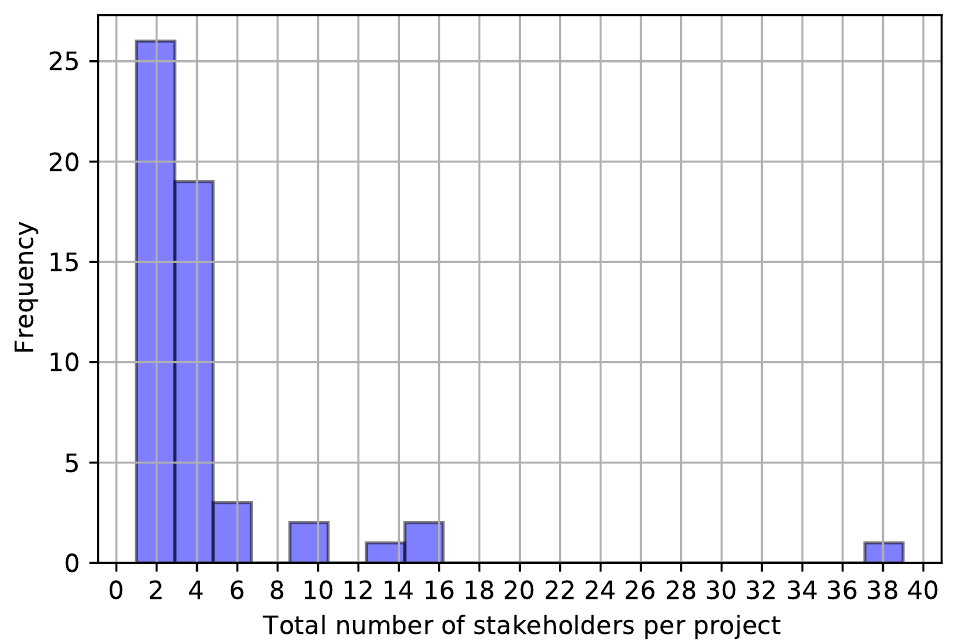
Figure 15. A histogram showing a distribution of stakeholders per blockchain project in Thailand.